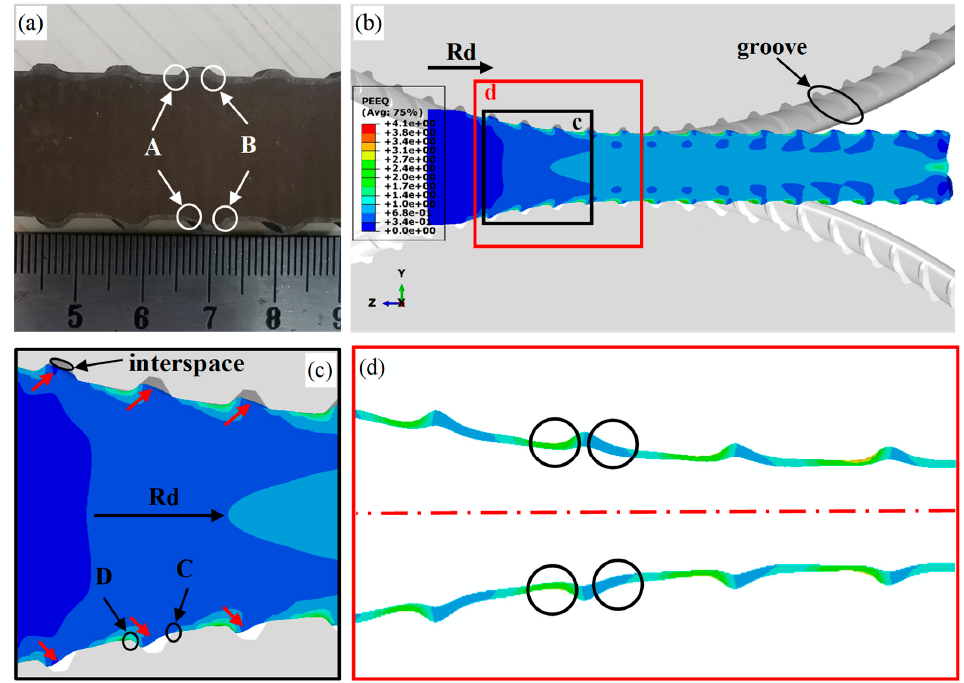
Figure 11. DSS/LAS-clad rebar and FEM simulation: ( a ) longitudinal section of the DSS/LAS-clad rear, ( b ) result of the FEM simulation based on ABAQUS, ( c ) deformation of transverse ribs, ( d ) variation in DSS cladding thickness.